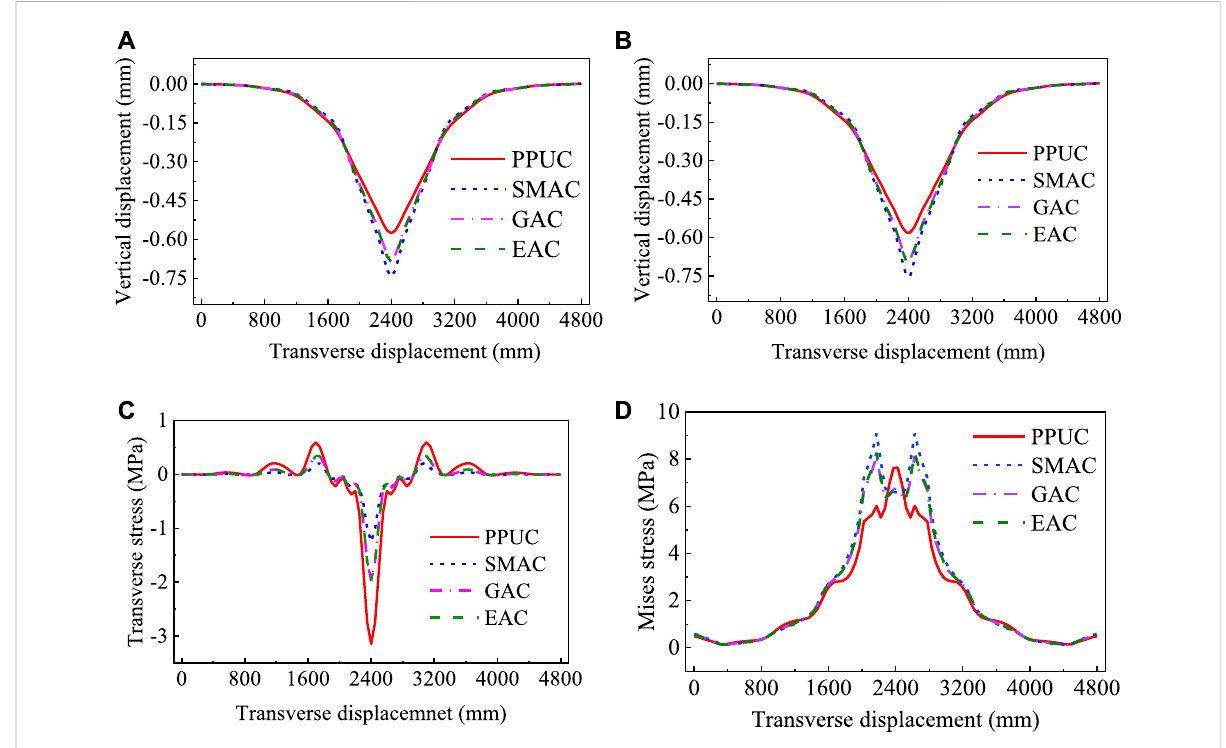
FIGURE 17 Comparison results of single-layer pavement structure using different materials. (A) Vertical displacement of the pavement; (B) Vertical displacement of the steel deck; (C) Transverse tensile stress of the pavement; (D) Mises stress of the steel bridge